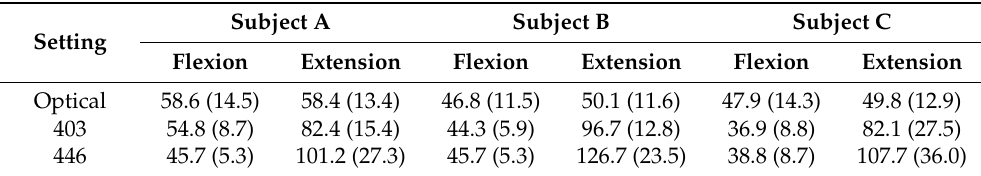
Table 4. Joint angular excursions in the flexion and extension phases calculated using the chair with embedded laser range finders in two thigh length settings and the optical motion capture system in all